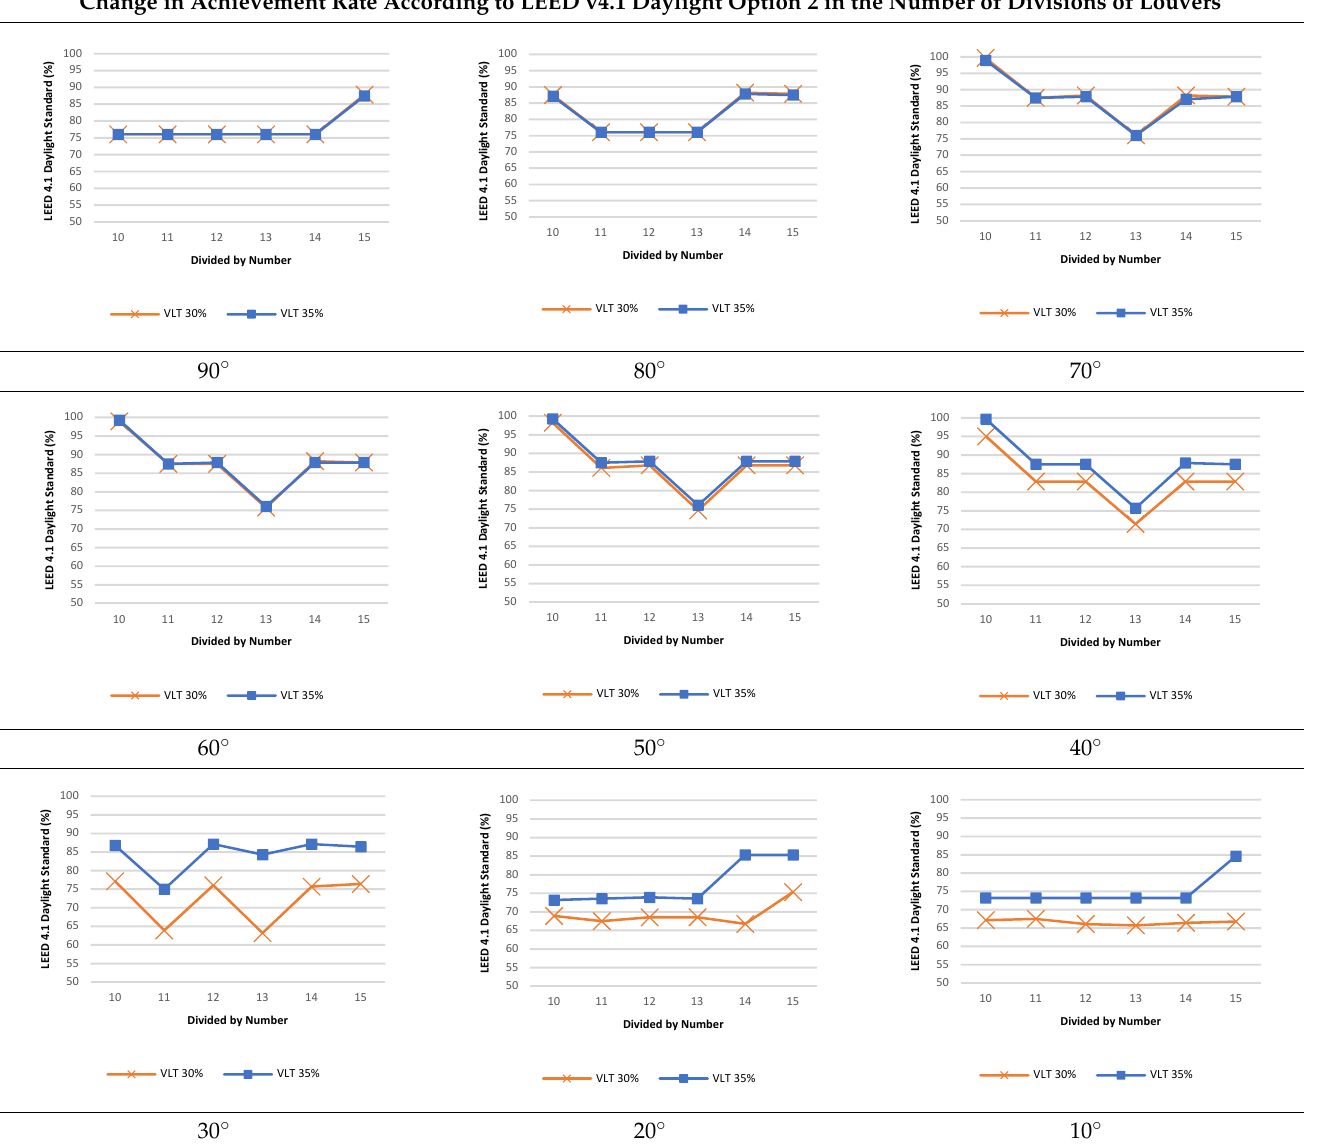
Table 10. Analysis of target illuminance attainment rate for louvers of VLT 30% to 35%. Change in Achievement Rate According to LEED v4.1 Daylight Option 2 in the Number of Divisions of Louvers